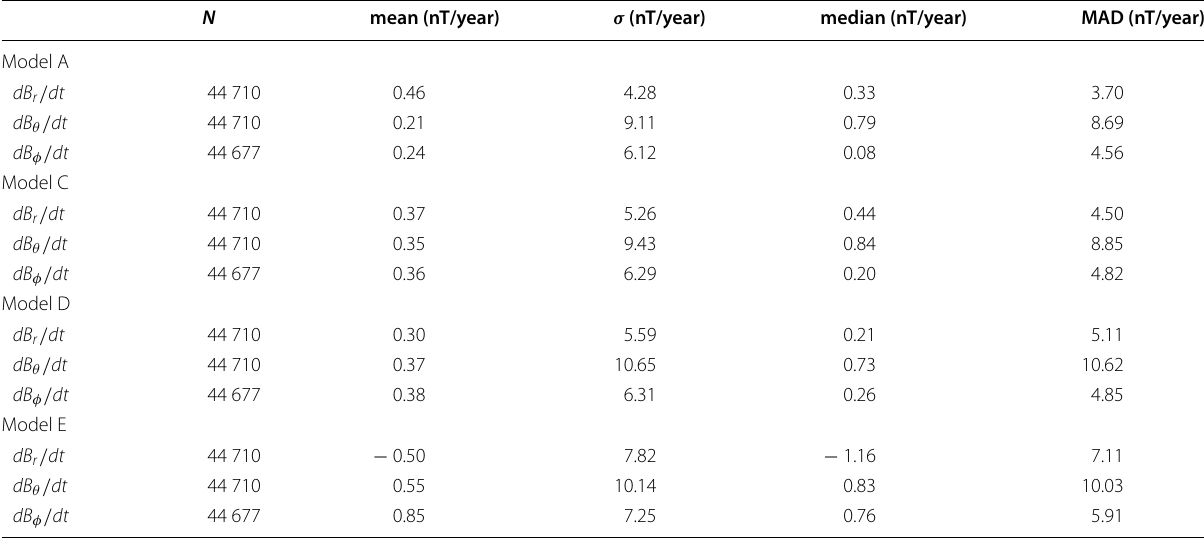
Model B statistics are not shown since that model is not constrained during the